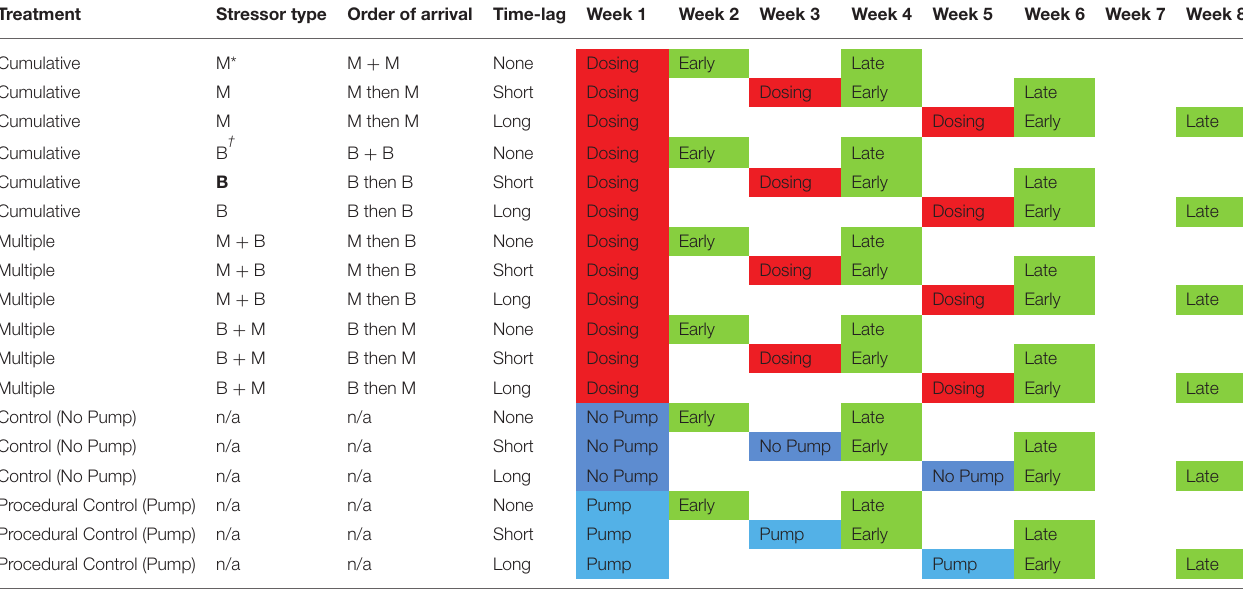
TABLE 1 | Dosing and sampling schedule implemented over the duration of the experiment, which ran for a total of 8 weeks at Malahide.